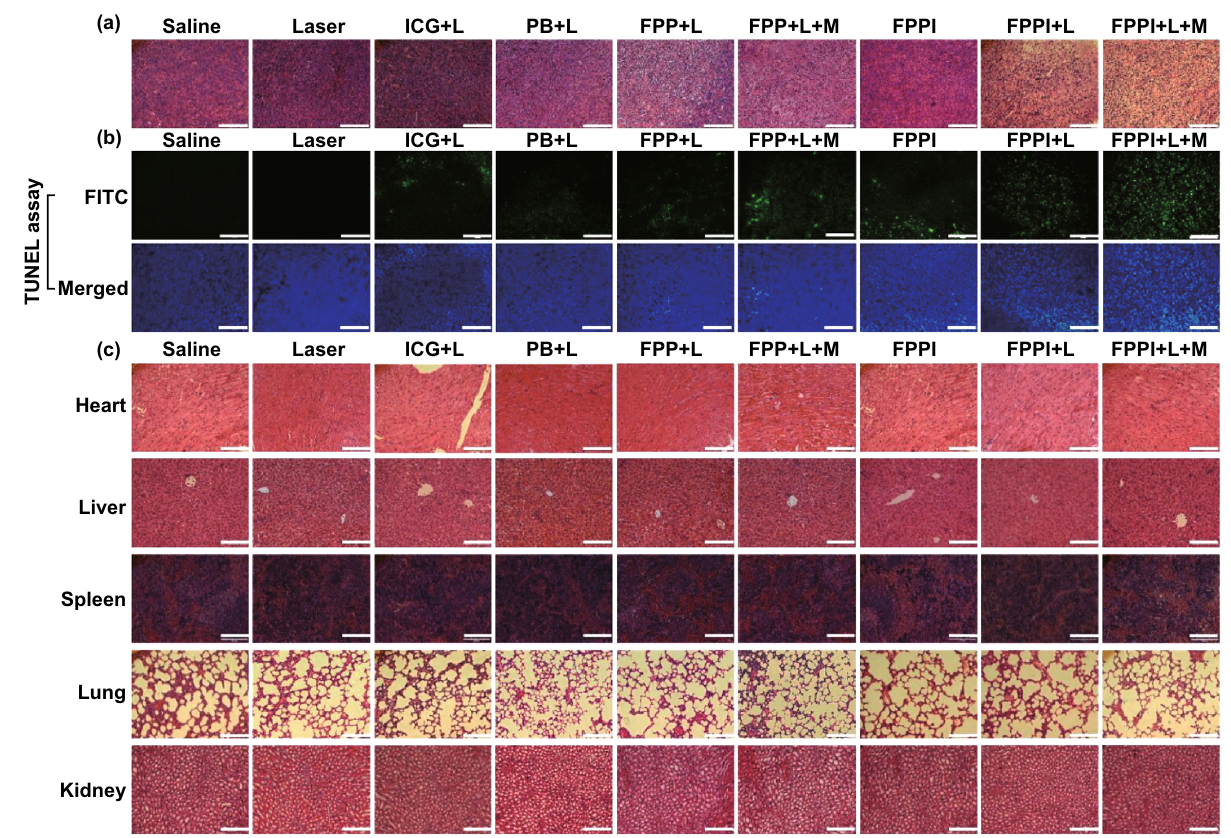
Fig. 8 Histological analyses of the excised tumors at day 14 post-injection by a H&E staining and b TUNEL assays (scale bars: 100 l m); c histological analysis of major organs by H&E staining at day 14 post-injection (scale bars: 200 l m). ‘‘L’’ and ‘‘M’’ denote laser irradiation and magnetic guidance,